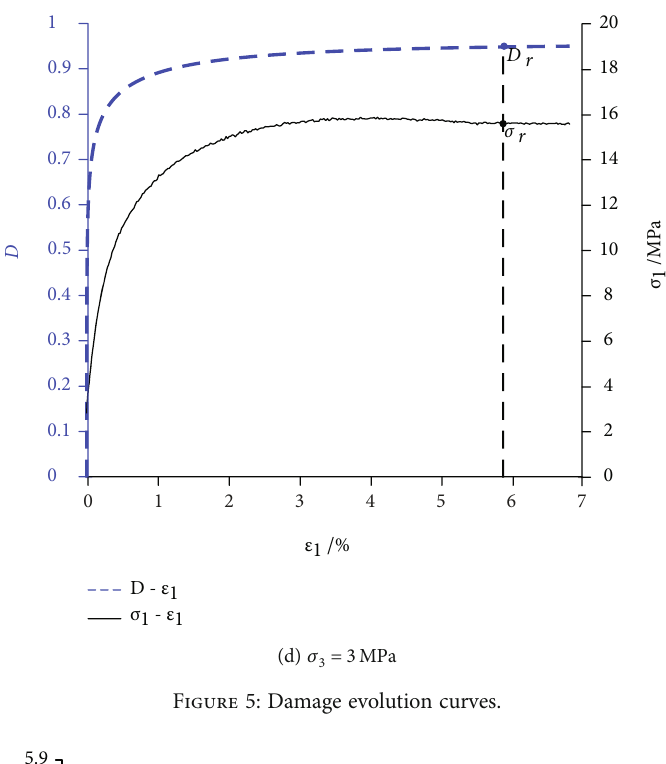
Figure 5: Damage evolution curves.